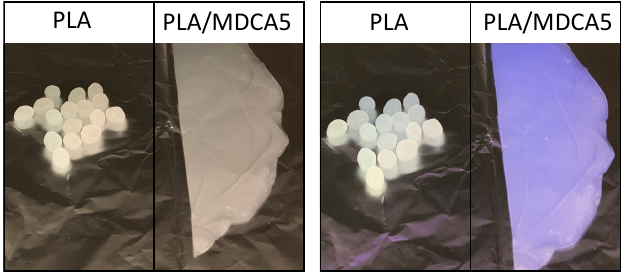
Figure 9. PLA and PLA / MDCA5 under natural light ( left ) and under UV light ( λ = 254 nm) ( right ).